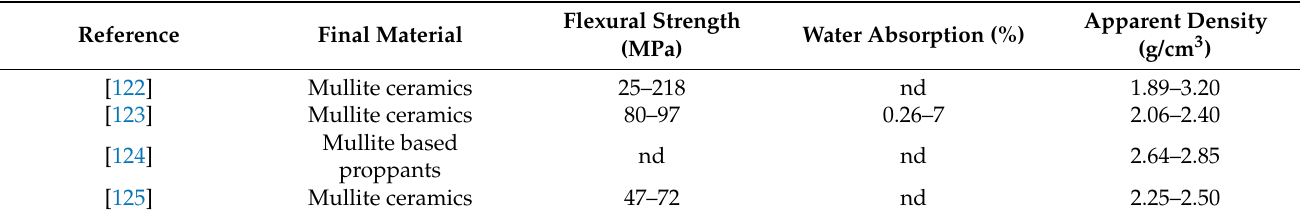
Table 14. Technological properties of mullite-based materials developed from coal gangue.